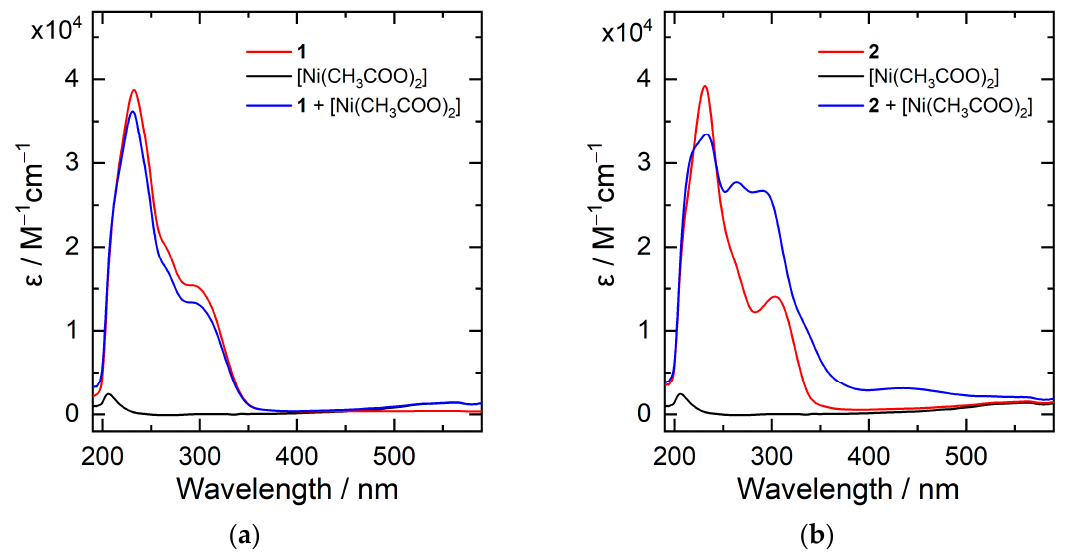
Figure 1. UV-Vis spectra of 1 ( a ) and 2 ( b ) measured in methanol in the absence and presence of one equivalent of Ni(II) acetate.